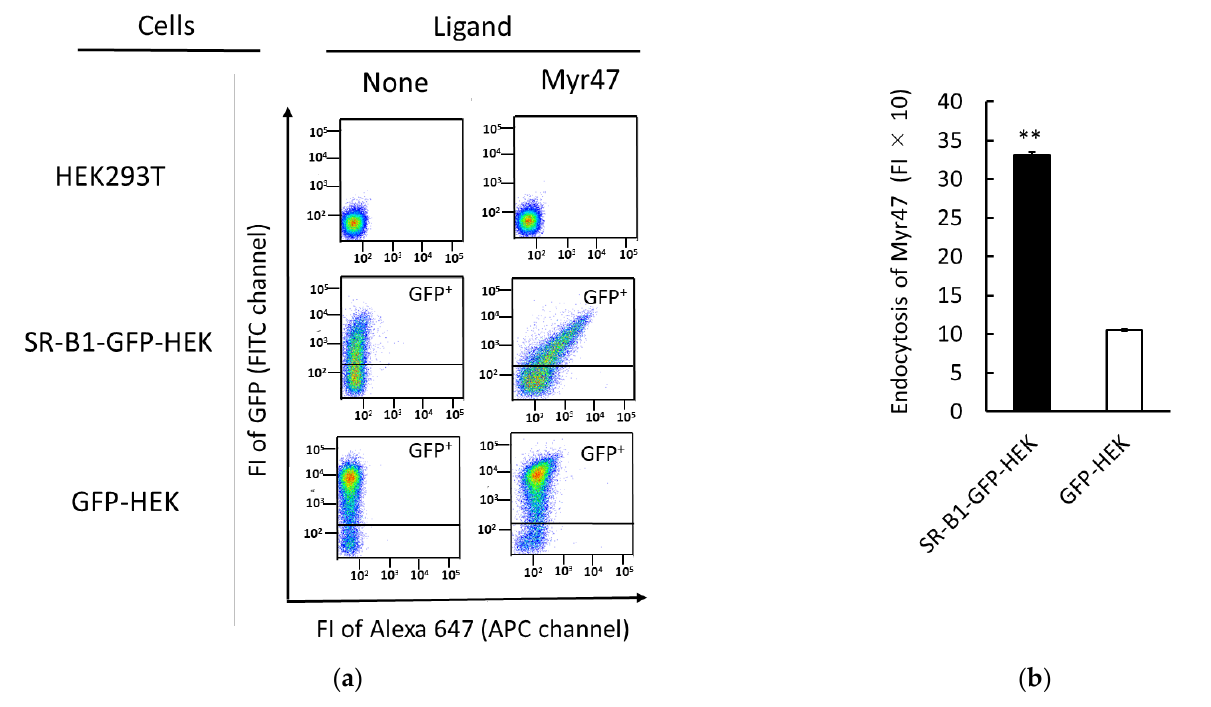
Figure 4. Endocytosis of Myr47 in SR-B1-GFP-HEK cells. Indicated cells were subjected to Myr47 uptake assays. ( a ) Two-parameter dot plot analyses of Myr47 uptake in HEK293T, SR-B1-GFP-HEK, and GFP-HEK cells. To obtain these plots, 30,000 cells of each sample were subjected to the analysis. Vertical and horizontal axes of plots are indicated as FI of GFP and Myr47 with flow cytometric channels used for the assays, respectively. ( b ) Quantified Myr47 endocytosis in SR-B1-GFP-HEK and GFP-HEK cells. Both Myr47 uptake and binding in GFP + subsets in the two-parameter dot plots of SR-B1-GFP and GFP-HEK cells were determined. Quantification of Myr47 endocytosis was carried out by calculating the subtraction of FI of Myr47 bindings from that of Myr47 uptakes. Data are expressed as means and standard errors (vertical bars) in triplicate assays. To obtain these data, 10,000 cells were applied for the analysis. Statistical analysis was carried out using Student’s t -test; ** indicates p < 0.01.